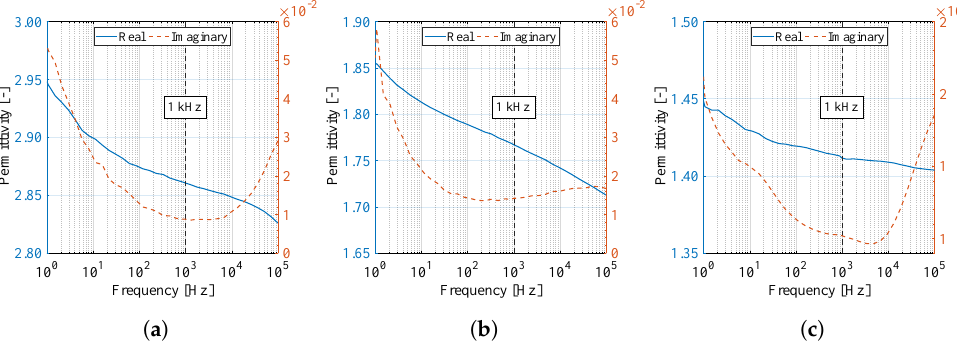
Figure 13. Real and imaginary permittivity curves of ( a ) PVDF, ( b ) PVDF/PA6, and ( c ) PA6 material as a function of frequency from 1Hz to